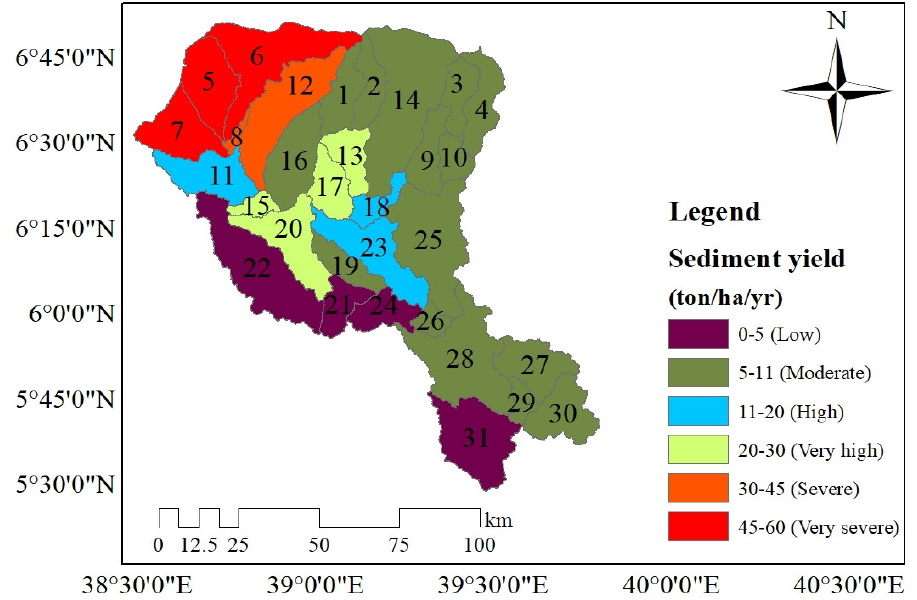
Figure 7. Spatial variability of sediment yield for Genale Dawa-3 dam watershed.